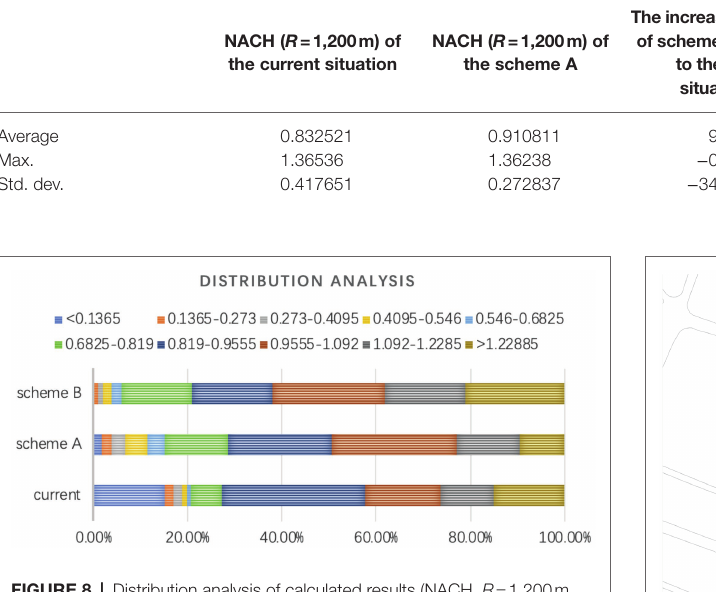
TABLE 4 | Distribution comparison of the calculated results. Value of NACH ( R = 1,200 m) <0.1365